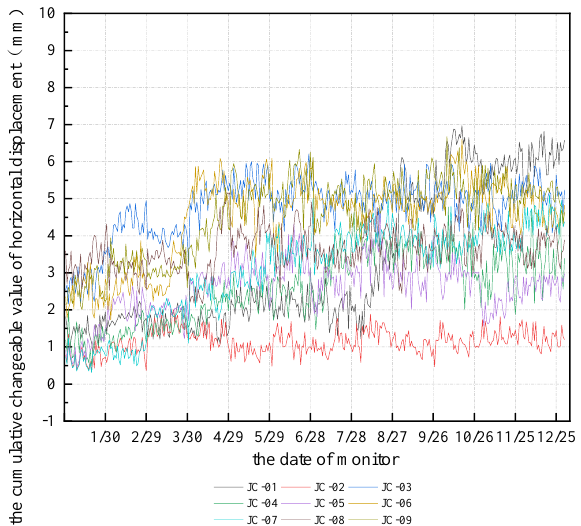
Figure 32. The cumulative changeable curve on annual slope surface horizontal displacement.